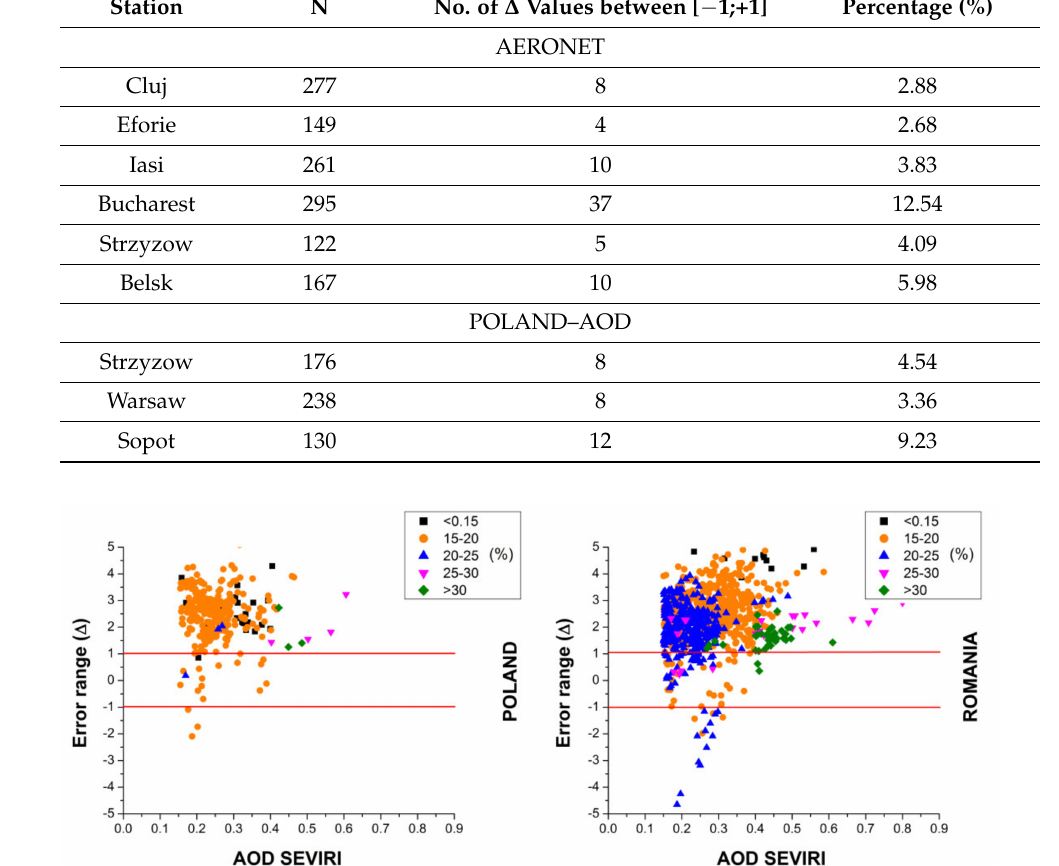
Table 4. AOD uncertainties distribution (AERONET - 675 nm; POLAND–AOD - 674 nm).